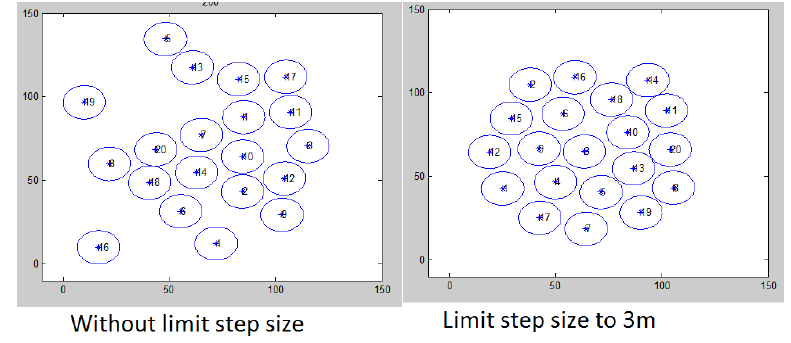
Figure 5. Limit step size, and N = 20.